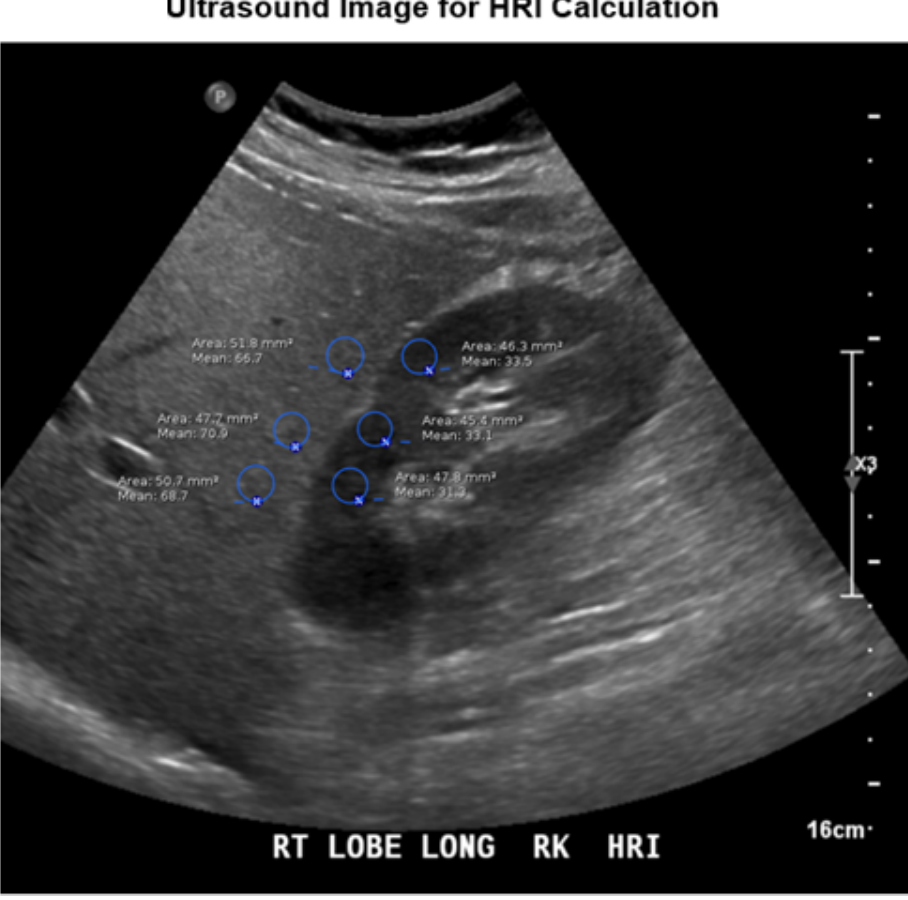
Figure 1. Example of HRI measurements. HRI is determined by placing region of interest markers at the same depth in the kidney and the adjacent liver parenchyma.